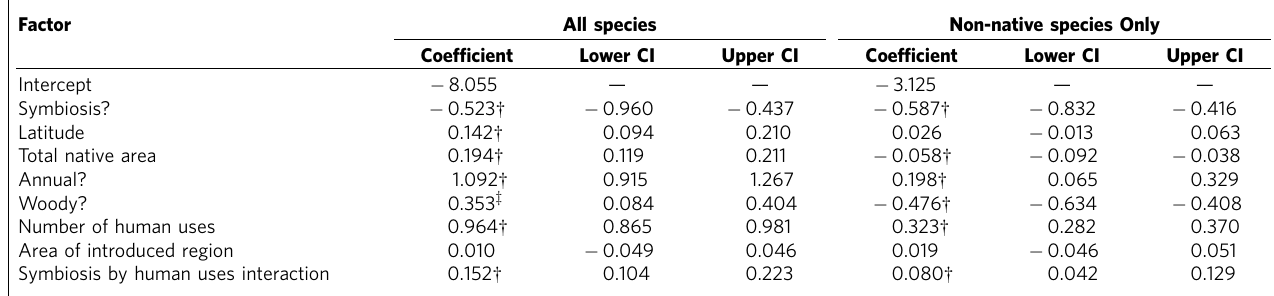
CI, 95% confidence interval. Symbiosis is incorporated into the model as the presence or absence of the trait, with the inclusion of other factors found to predict introductions in our legume dataset. A negative coefficient indicates lower introduction success for symbiotic legumes compared with non-symbiotic legumes. We excluded non-significant interaction terms. 95% confidence intervals were obtained from parametric bootstrapping. Each response variable is modelled at the species by region level, and the model included a species and a region random effect to account for non-independence of observations within species or regions. The estimated variance for the species and region random effects respectively were 4.83 and 0.85 for the all species model, and 0.9 and 1.43 for the non-native species only model. w 99.9% CI does not overlap zero. z 99% CI does not overlap